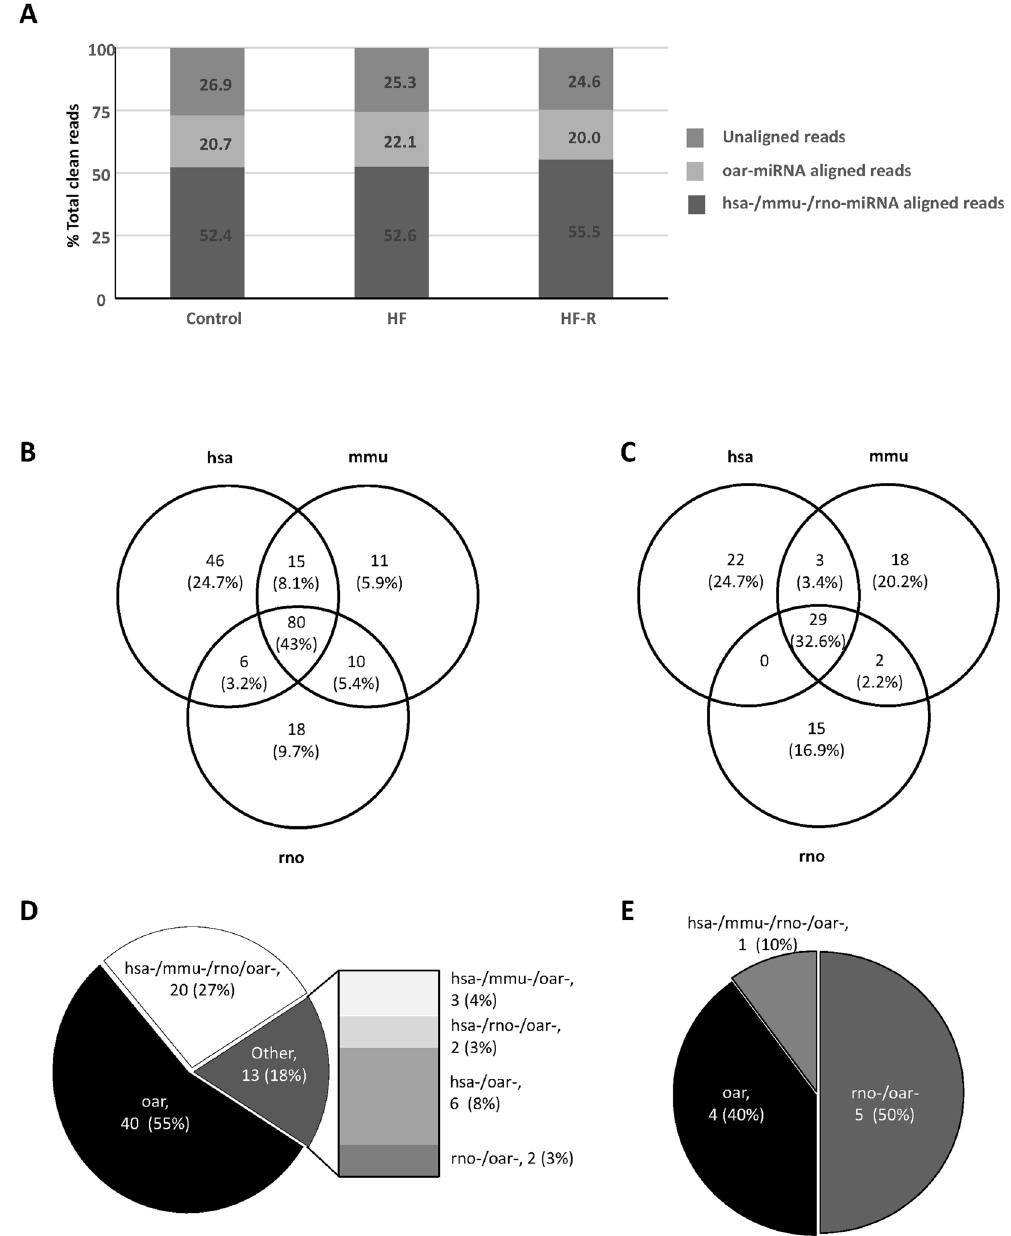
Figure 2. Analysis of NGS miRNA sequences. ( A ) Summary of NGS reads of 15–30 nts alignment to hsa-, mmu- and rno- and known oar-miRNAs (miRBase v21 miRNA). ( B and C ) Distribution of 186 novel oar- miRNAs perfectly aligned (100%) and 89 oar-miRNAs 70–99% aligned, respectively, with hsa-, mmu- and rno- miRNAs. ( D and E ) Distribution of 73 known oar-miRNAs aligned perfectly and 10 aligned 70–99% with hsa-, mmu- and rno-